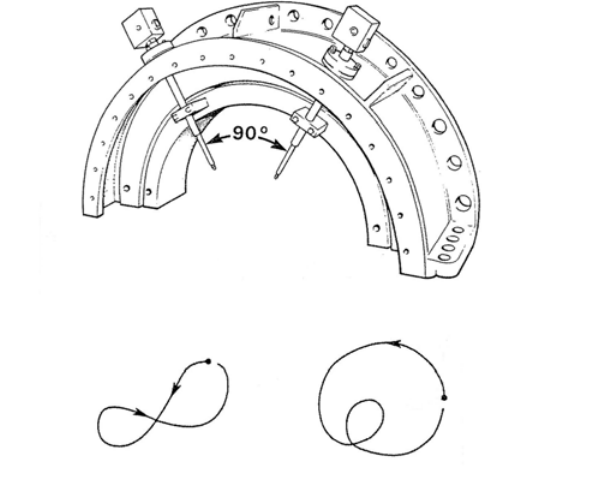
Figure 18 – View of the bearing cover showing the non-contact probes for measuring the dynamic path according to the configuration of the Bently Nevada